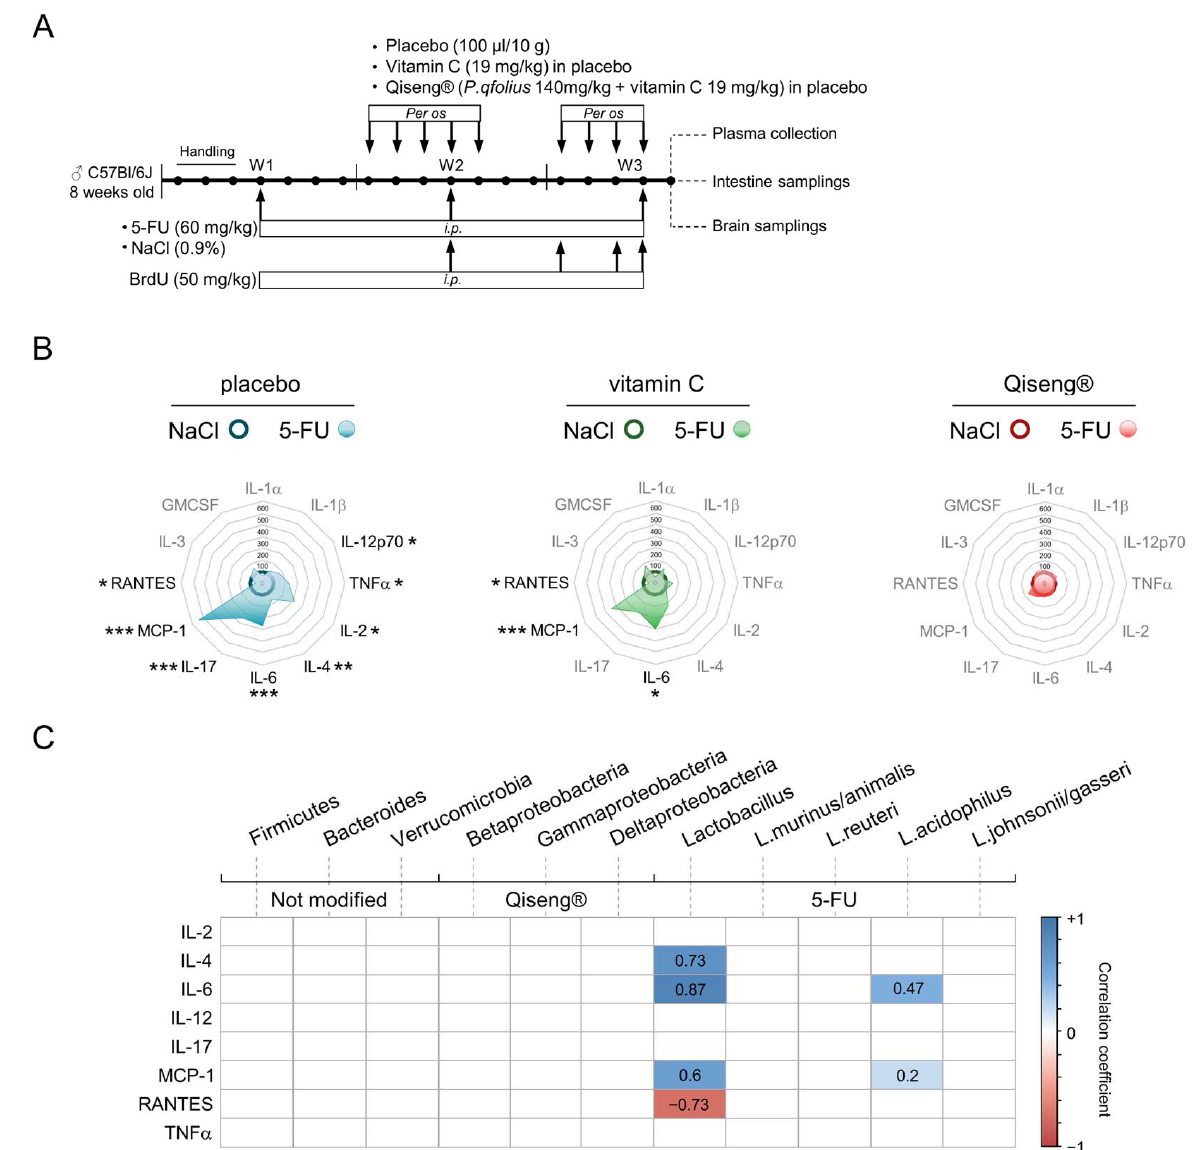
Figure 7. Impact of 5-FU in the absence or the presence of placebo, vitamin C or Qiseng ® on plasma levels of pro-inflammatory, pluripotent, chemotactic and leukocyte growth cytokines. ( A ) Schematic timeline of treatments and intestine sampling from the different groups of mice for studying plasma cytokines and brain neuroinflammation. ( B ) Radar plots representation summarizing the impact of NaCl/placebo, vitamin C or Qiseng ® and 5-FU/placebo, vitamin C or Qiseng ® treatments on plasma cytokine levels of treated mice. Cytokines in gray indicate no difference between NaCl and 5-FU conditions. Data represent the normalized mean difference between NaCl and 5-FU as percentage. NaCl/placebo ( n = 9), 5-FU/placebo ( n = 8–9), NaCl/vitamin C ( n = 8–9), 5-FU/vitamin C ( n = 6–8), NaCl/Qiseng ® ( n = 10), 5-FU/Qiseng ® ( n = 8–9). * p < 0.05, ** p < 0.01, *** p < 0.001. ( C ) Correlation between the different bacteria taxa (except domains) evaluated by qPCR and the different cytokines measured in plasma of NaCl/ and 5-FU/placebo, vitamin C and Qiseng ® mice. Beta-, Gamma- and Delta-proteobacteria are the significantly modified group compared with oth- ers under Qiseng ® treatment. Lactobacillus and some subspecies ( L. reuteri, acidophilus and john- sonii/gasseri ) corresponded to the taxa found increased after chemotherapy administration. Heatmap of Kendall correlation coefficients from medians: only significant correlations are displayed (adjusted p value < 0.05). The blue color indicates a positive correlation and the red color a negative